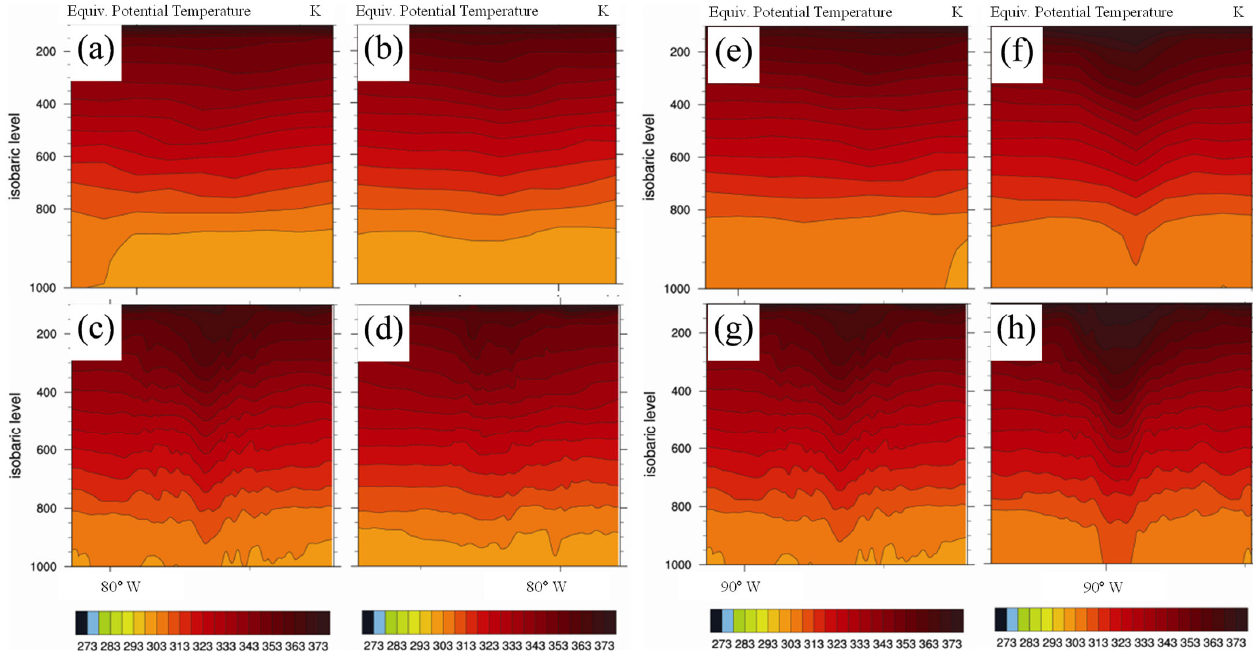
Figure 9. Cross ‐ sections showing the equivalent potential temperature (K) of the TC according to ( a , c , e , g ) 24 and ( b , d , f , h ) 48 h forecasts taken from the GFS (upper panels) and HRS/HLAPS (lower panels). The left and right panels are for Hurricanes Dennis and Katrina, respectively.